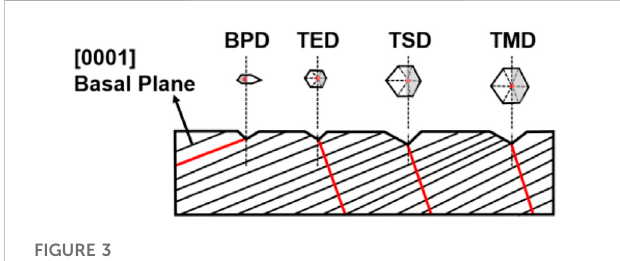
FIGURE 3 Schematic diagram showing the correlation between the dislocation lines and etch-pit morphologies in 4H-SiC epitaxial layers deposited on off-axis sliced substrates. The gray part of the etch pit denotes the etched surfaces near the dislocation lines.